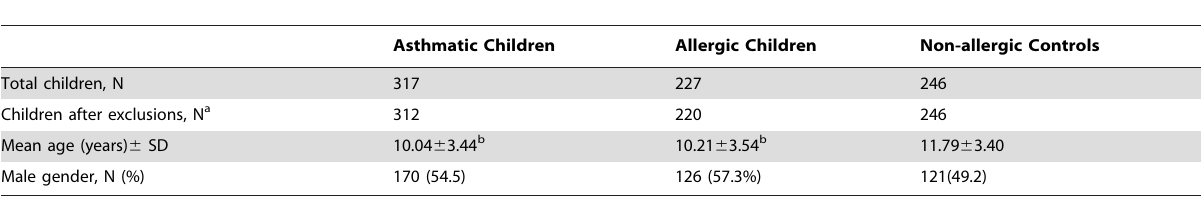
Table 3. Characteristics of the discovery Caucasian population.